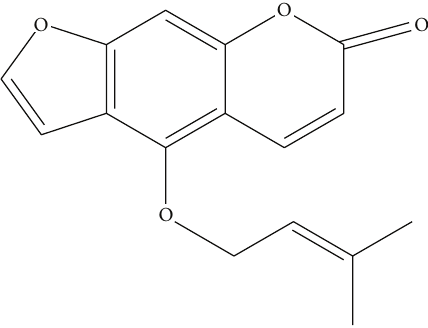
Figure 1: Structure of